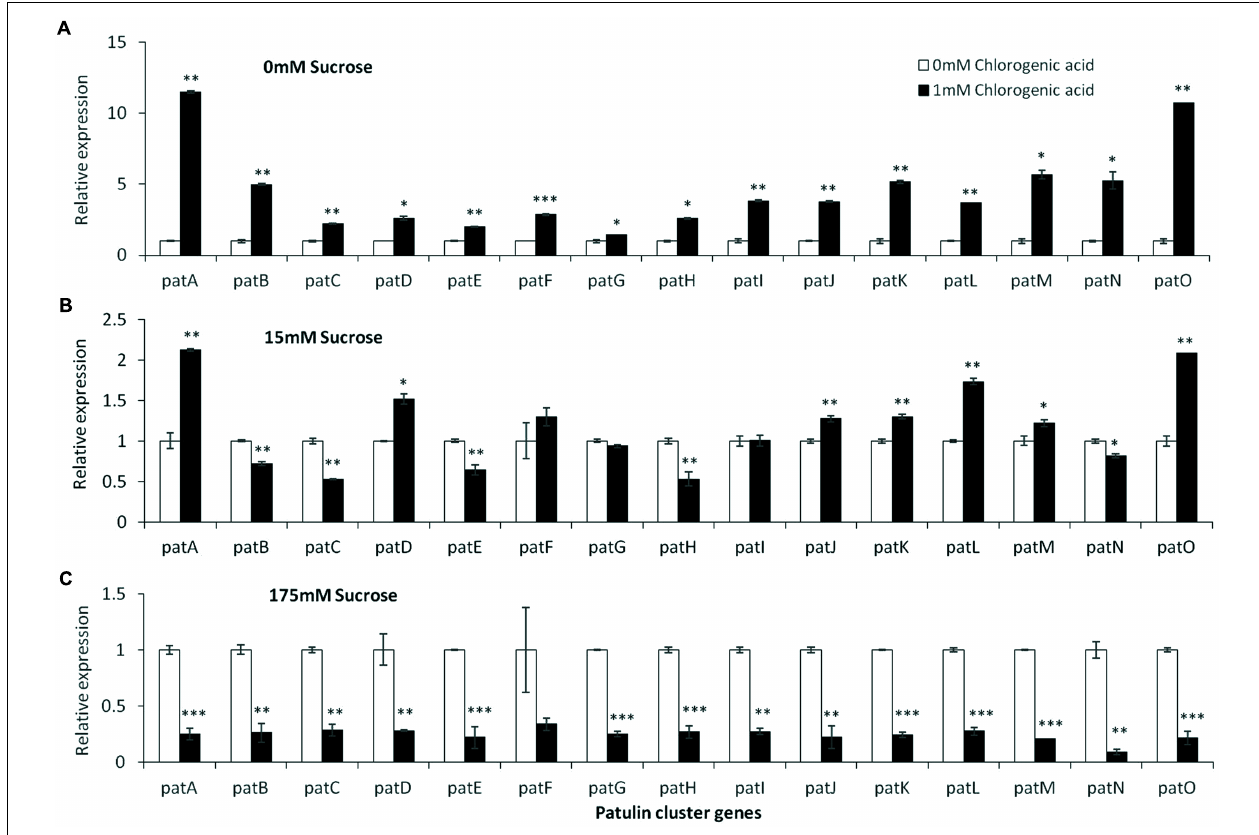
FIGURE 7 | pat genes cluster (PGC) relative expression as affected by chlorogenic acid and different levels of sucrose. Solid SM media at initial pH 5.0 amended with 0 (A) , 15 (B) , and 175 mM (C) sucrose was combined with increasing concentrations of chlorogenic acid from 0 and up to 1 mM. The media was inoculated with 100 µ l of a 10 6 spore/ml suspension and the relative expression patA, patB, patC, patD, patE, patF, patG, patH, patI, patJ, patK, patL, patM, patN, patO between both treatments were compared. Expression was evaluated 3 days post-inoculation after the mycelia was sampled from the culture plates. Average values ( ± SE) of five replicates are reported. Experiments were repeated three times and results of a single representative experiment are shown. For statistical analysis, the unpaired student t -test was used with significance defined as a P value ( ∗ P ≤ 0.05; ∗∗ P ≤ 0.01; ∗∗∗ P ≤